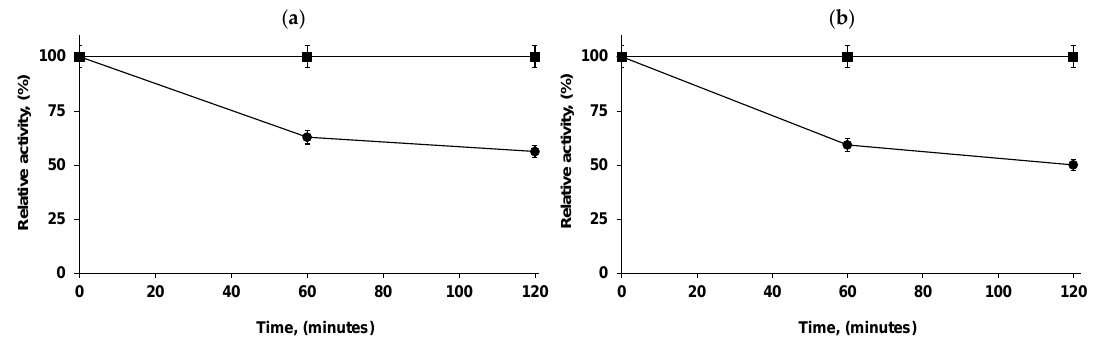
Figure 7. Immobilization courses on octadecyl methacrylate beads (ECR8806M) of ( a ) TLL (50 mg / g) and ( b ) ET (40 mg / g). Other specifications are described in the Methods section. Solid squares: reference and solid circles: supernatant.